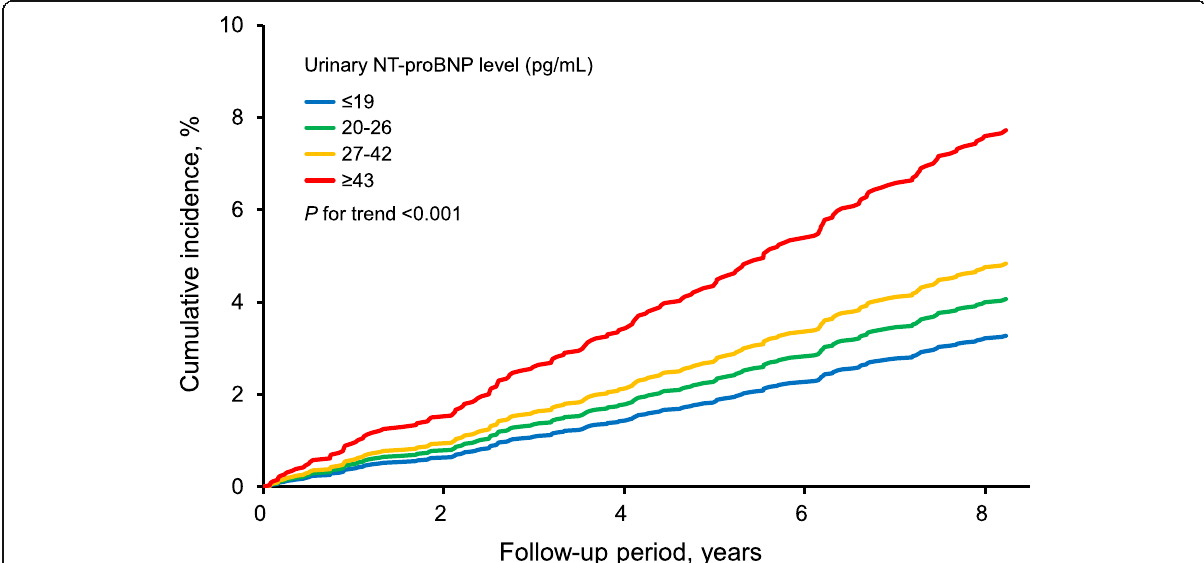
Fig. 2 Age- and sex-adjusted cumulative incidence of total cardiovascular disease according to the urinary NT-proBNP levels. Abbreviation: NT- proBNP , N-terminal pro – B-type natriuretic